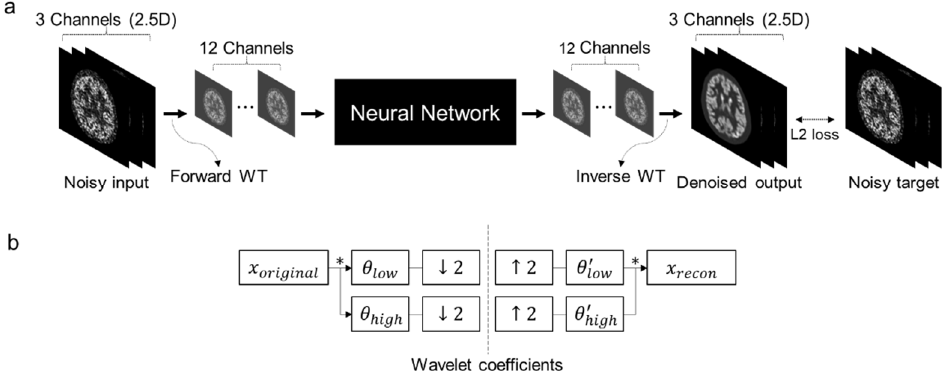
Figure 1. ( a ) Schematic of the proposed neural network. The forward and inverse wavelet transform (WT) performed before and after passing the deep neural network has trainable coefficients. To achieve the continuity of 3D data, we used a 2.5D input and output. ( b ) Schematic explanation for the 1D wavelet transform and its inverse transform. ∗ denotes the convolution with Haar filter banks ( θ . ), which were learnable parameters during the training. The arrows show the dyadic down sampling ( ↓ 2 ) and upsampling ( ↑ 2 ).